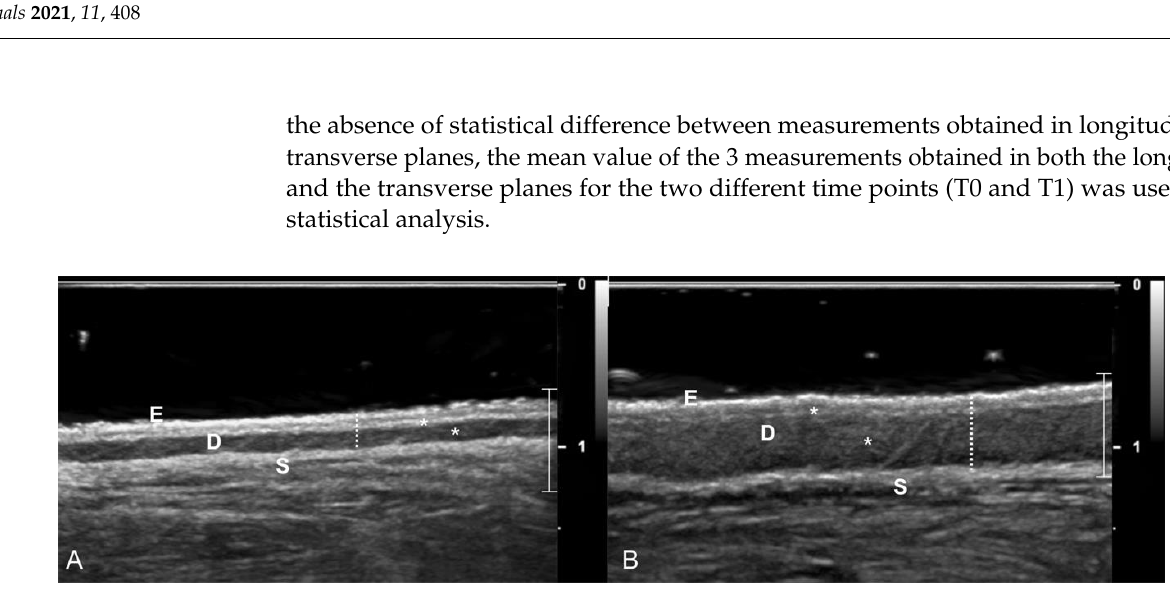
Figure 1. Ultrasonographic appearance of the neck skin of a dog with a skin thickness < 5 mm ( A ) and a dog with a skin thickness > 5 mm ( B ). Three distinct layers are clearly recognizable: the epidermal echo entry (E), the dermis (D) and the subcutaneous tissue (S). Note that the echogenicity of the second layer (D) is not uniform, and two distinct bands (*) with different echogenicities are recognizable. Measurements of the skin (the dotted lines) showed notably different skin thicknesses between the two dogs. The focal zone (white bar) and the graduated scale (0–1 = 1 cm) are displayed on the right of each image.